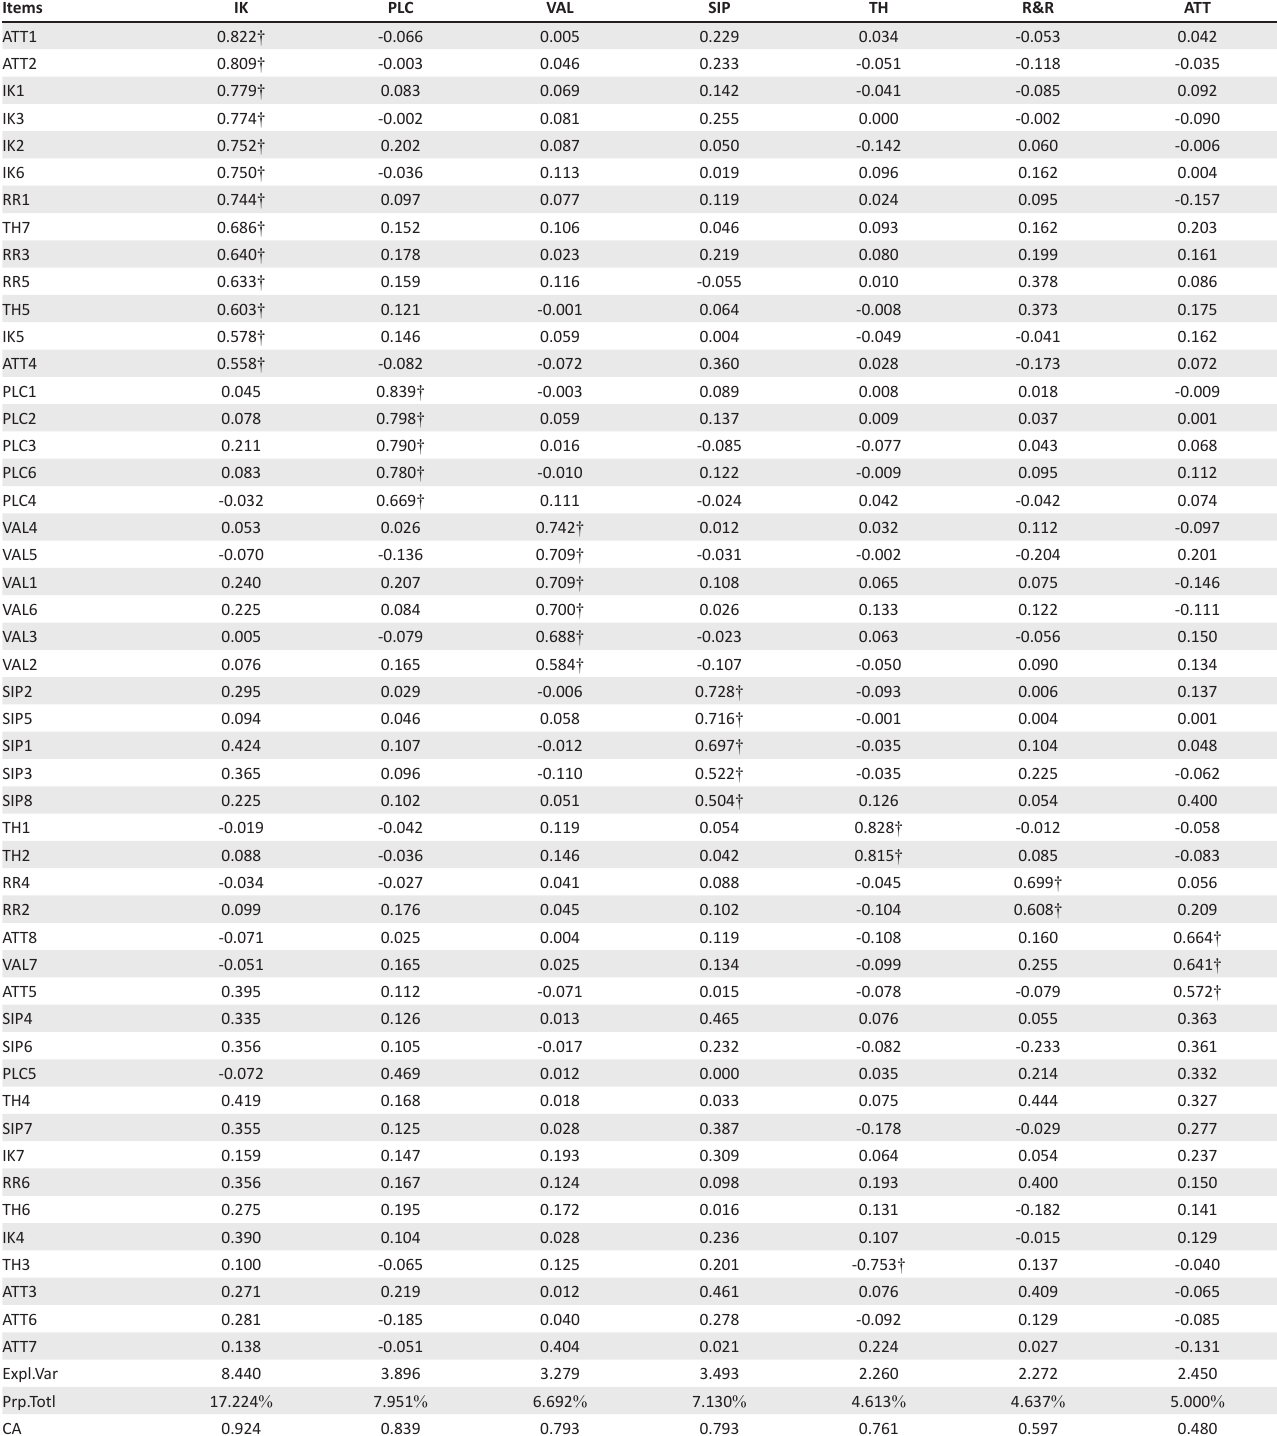
TABLE 2: Factor structure of the